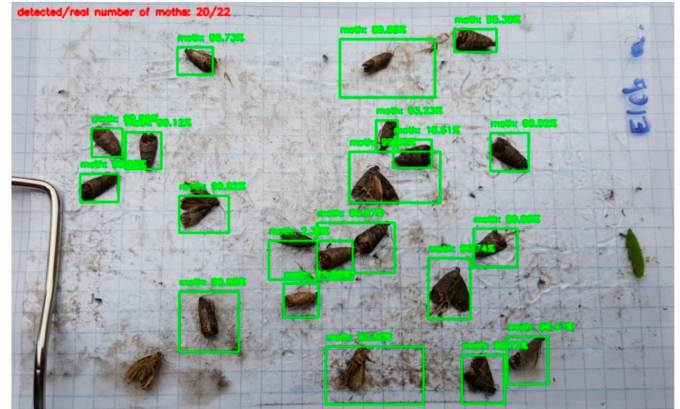
Figure 10. Detected moths with